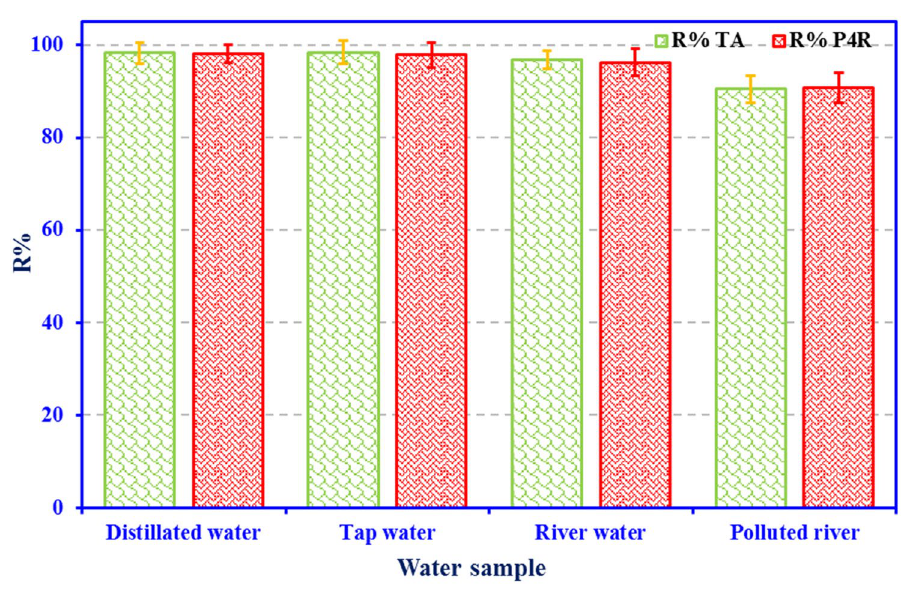
Figure 12. Removal efficiency of ZnS/CuO-CNT for TA + P4R dyes in various water